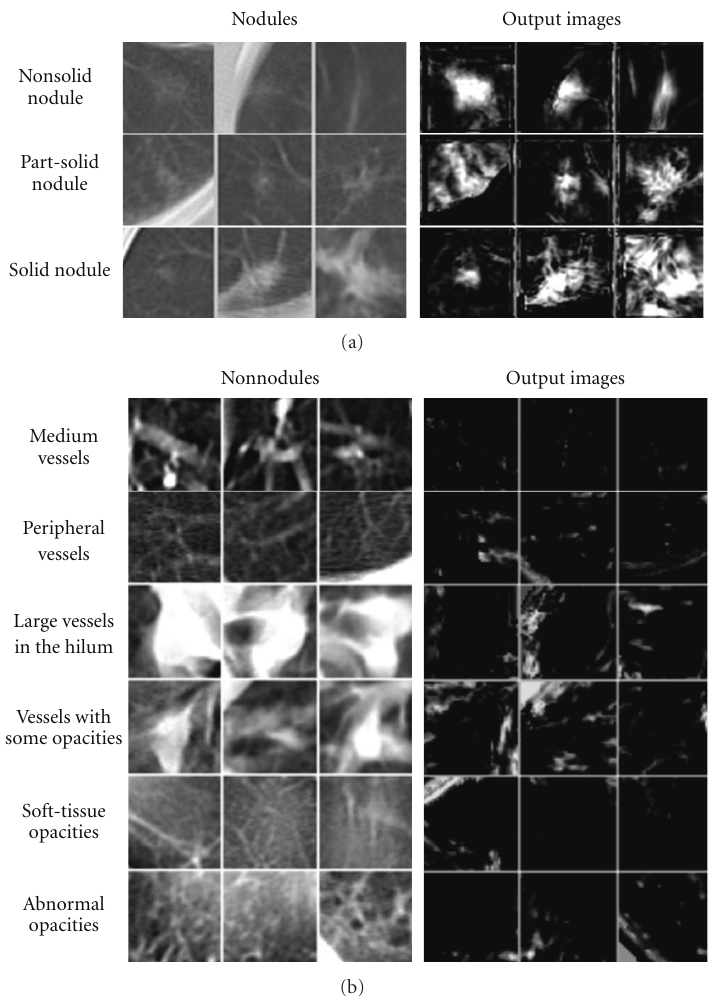
Figure 12: Illustrations of various types of nontraining nodules and nonnodules and corresponding output images of the trained MTANN. Nodules are represented by bright pixels, whereas nonnodules are almost dark around the centers of